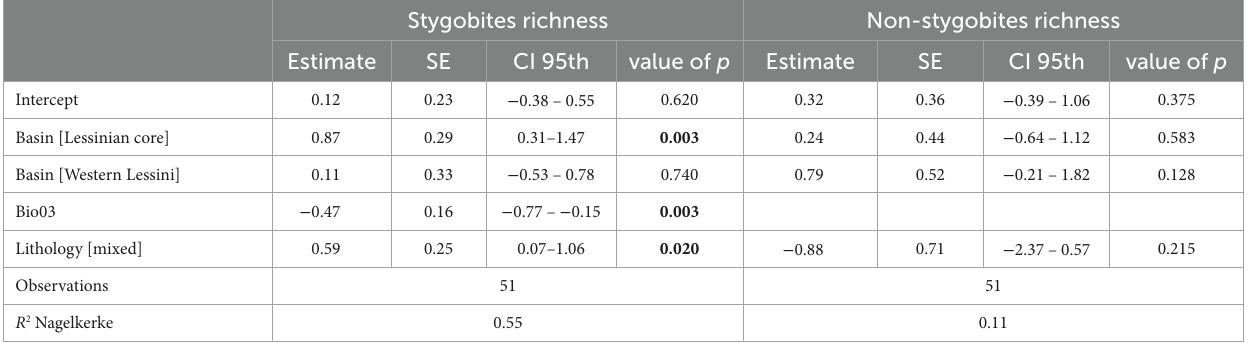
TABLE 3 Results from the refined Generalized Linear Model relating species richness of stygobitic (left) and non-stygobitic (right) copepods to the drainage basin the sampled caves belong to, isothermality (Bio03) and